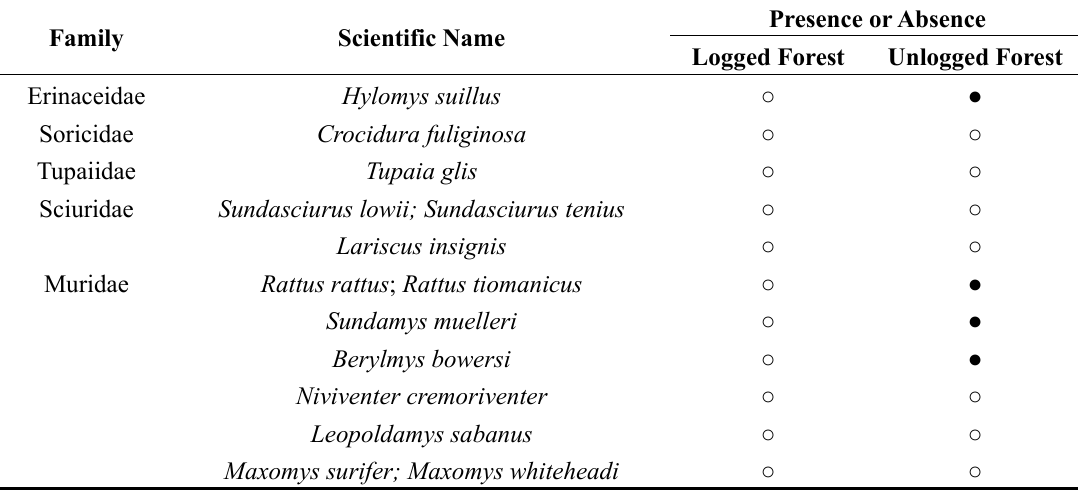
Table 1. Small mammal species documented in the block 5 of Temengor Forest Reserve, Perak, Malaysia. Open and closed circles denote the presence and absence of small mammal species in logged and unlogged